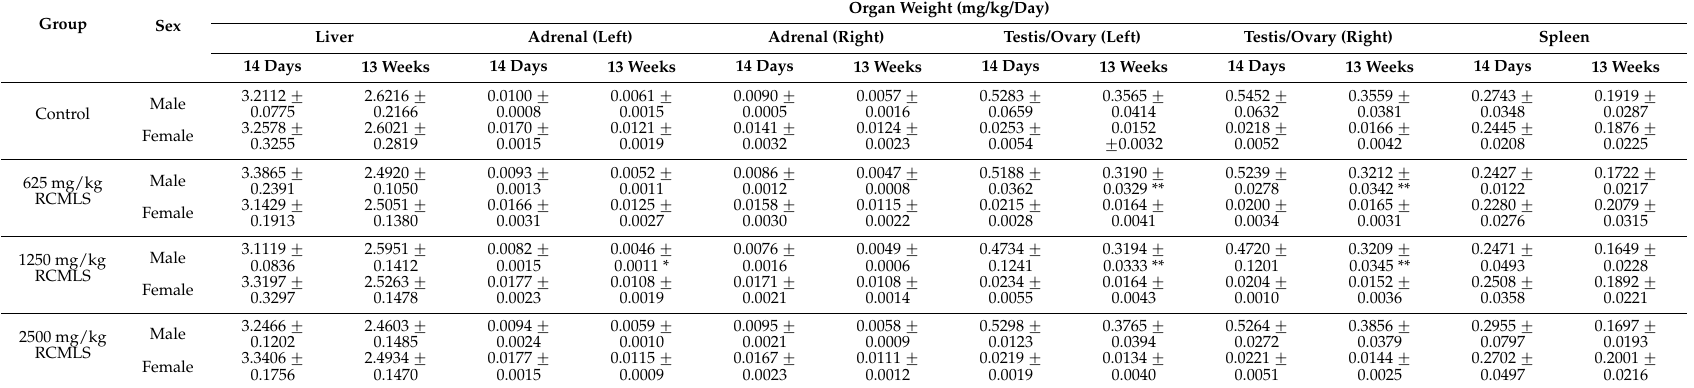
Table 10. Relative organ weights of male and female rats in 14 days repeated oral dose and 13 weeks repeated oral dose toxicity studies of the leaves and stems of Rubus coreanus